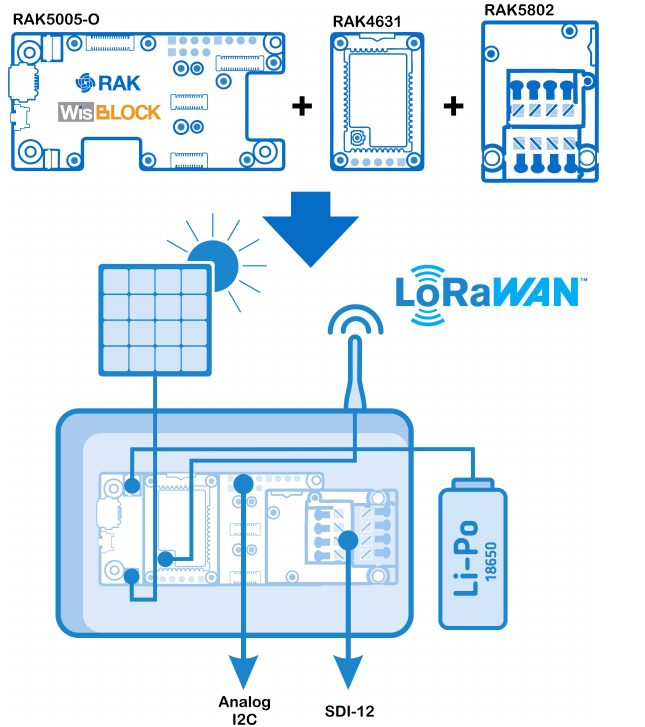
Figure 3. Module used in the developed system, based on RAK modular system